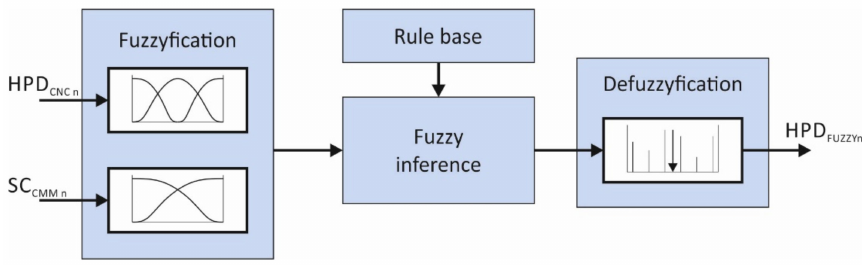
Figure 12. Diagram of the neuro-fuzzy